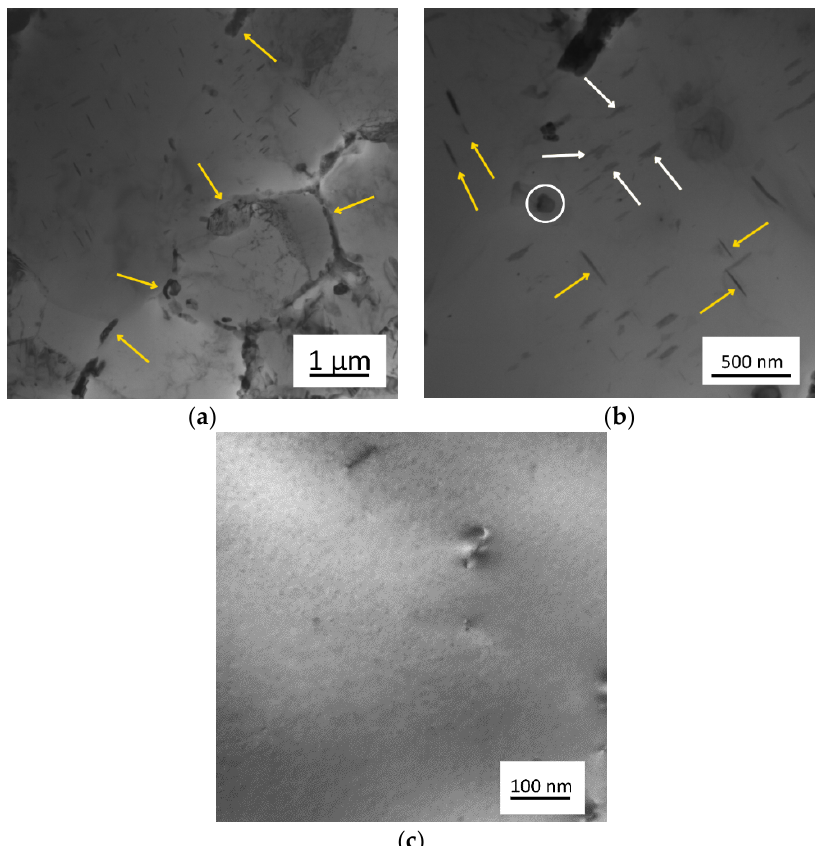
Figure 6. TEM bright field images of Al-Li-Cu-Mg-Zr-Sc alloy annealed in a linear heating regime up to 400 ◦ C. Coarse primary phase particles on grain boundaries ( a ), needles of S’ (yellow arrows), an Ag particle (white circle) and plates of θ ’ (white arrows) ( b ) and very fine Al 3 Sc 1-x Zr x particles spread through the whole volume ( c ).